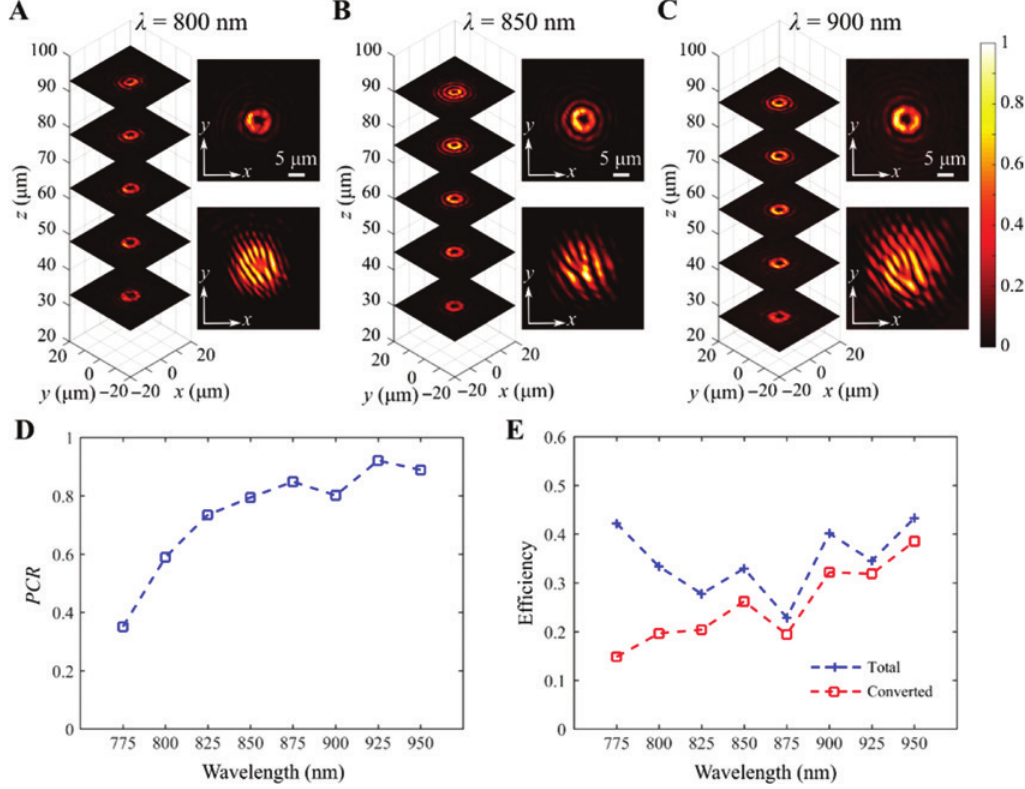
Figure 4: Optical characterization of the fabricated vortex-beam generator with the topological charge of l = 2. Left (A–C): focal spots evolution of the generated vortex beam along the optical axis ( z -axis) in cross-polarization. Right top (A–C): measured focal spot profiles at the corresponding focal planes in cross-polarization. Right down (A–C): interference pattern of the focused vortex beam and the copropagating Gaussian beam when the beam axes are tilted with respect to the other. (D) Measured PCR as a function of wavelength. (E) Measured efficiency as a function of wavelength. The total efficiency is defined as the ratio of the light intensity from the corresponding focal spot to the incident intensity, while the converted efficiency only considers the cross-polarized reflected beam. In all measurement, the x -polarized Gaussian beam is normally incident on the